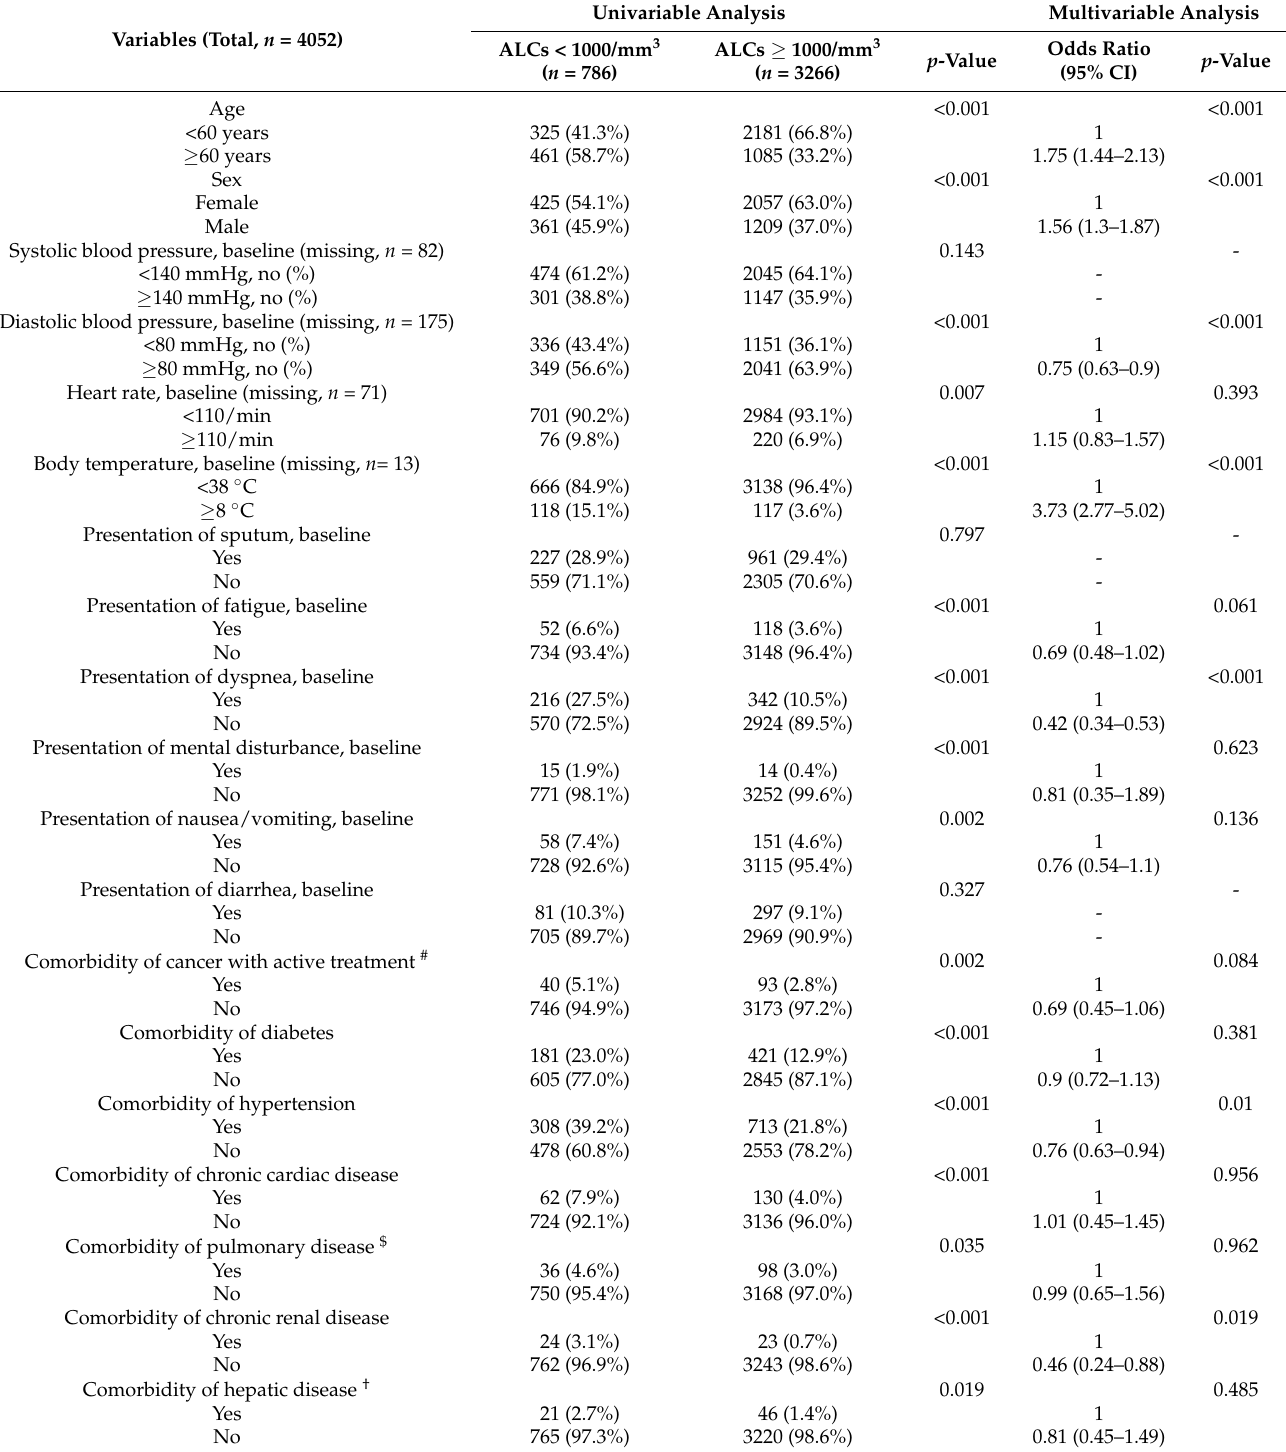
Table 1. Baseline characteristics of total cohort with/without lymphopenia (absolute lymphocyte counts [ALCs] < 1000/mm 3